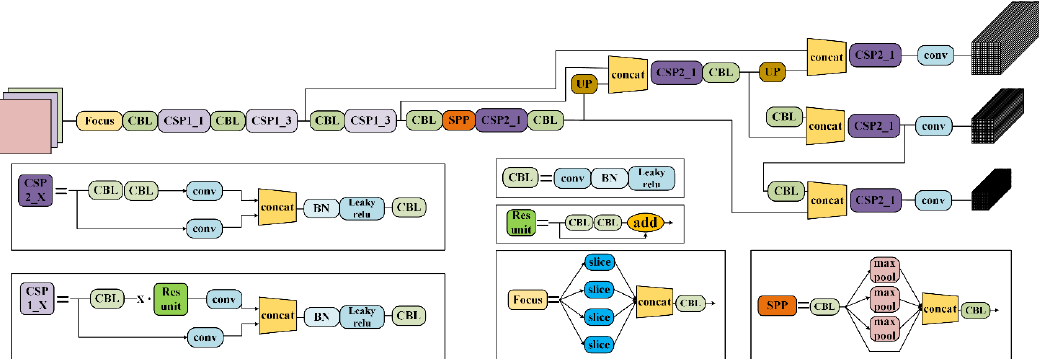
Figure 5. The overall structure of yolov5s.